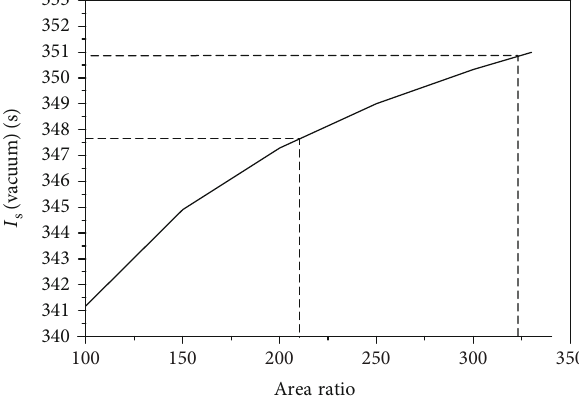
/ R = 1 : 633 , R / R = 0 : 816 , and β = 36 : 5 ° . u t d t